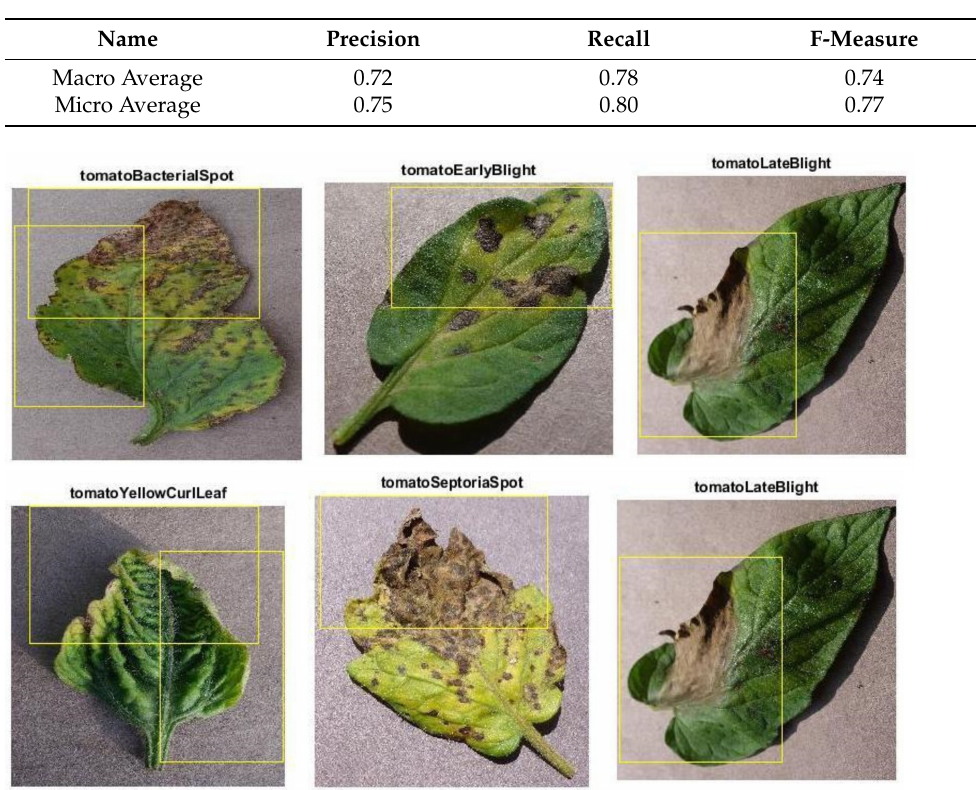
Table 11. The average performance of the suggested method on testing data.